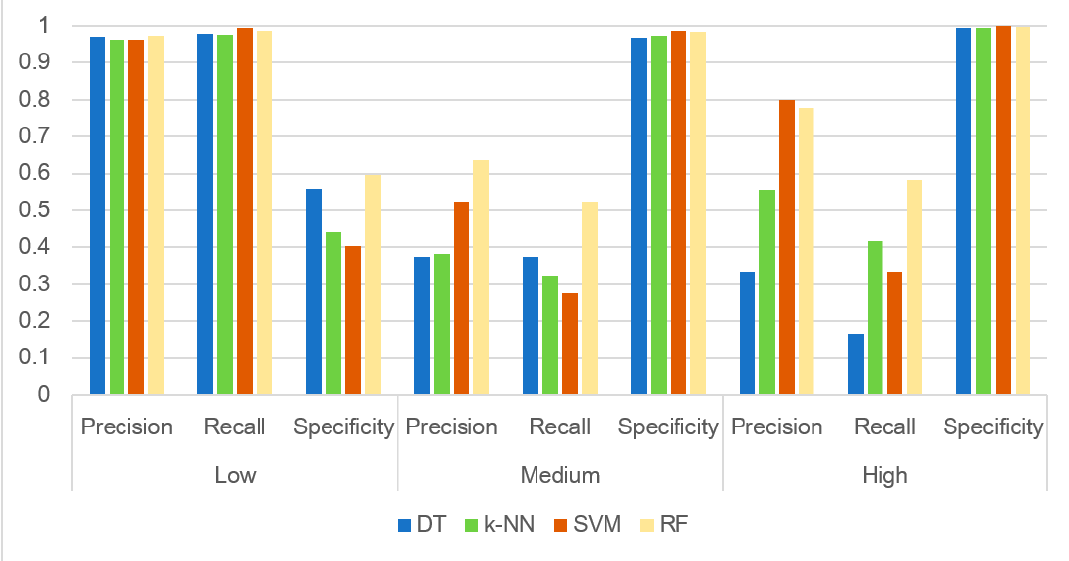
Figure 9. Analysis of the confusion matrix results for the four machine learning algorithms: DT, k-NN, SVM and RF. Results are presented for the three risk level classes—Low, Medium and High—and for three relevant metrics—precision, recall and specificity.